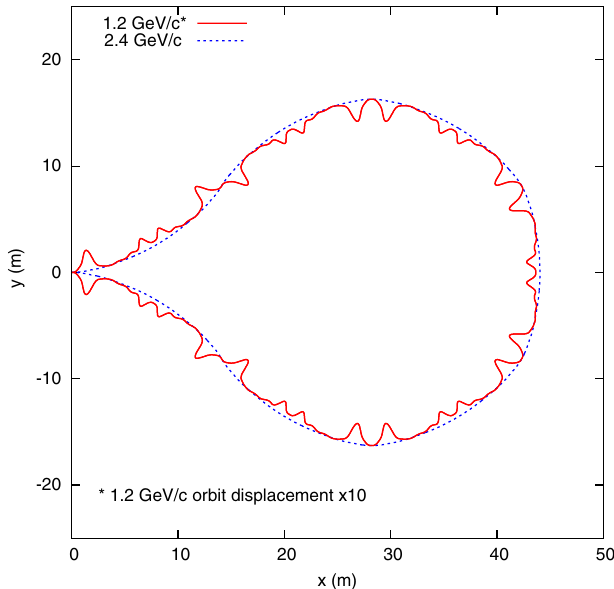
FIG. 6. Geometric layout of the 1.2 and 2 : 4 GeV =c reference orbits. The displacement of the 1 : 2 GeV =c orbit is magnified by a factor of 10.